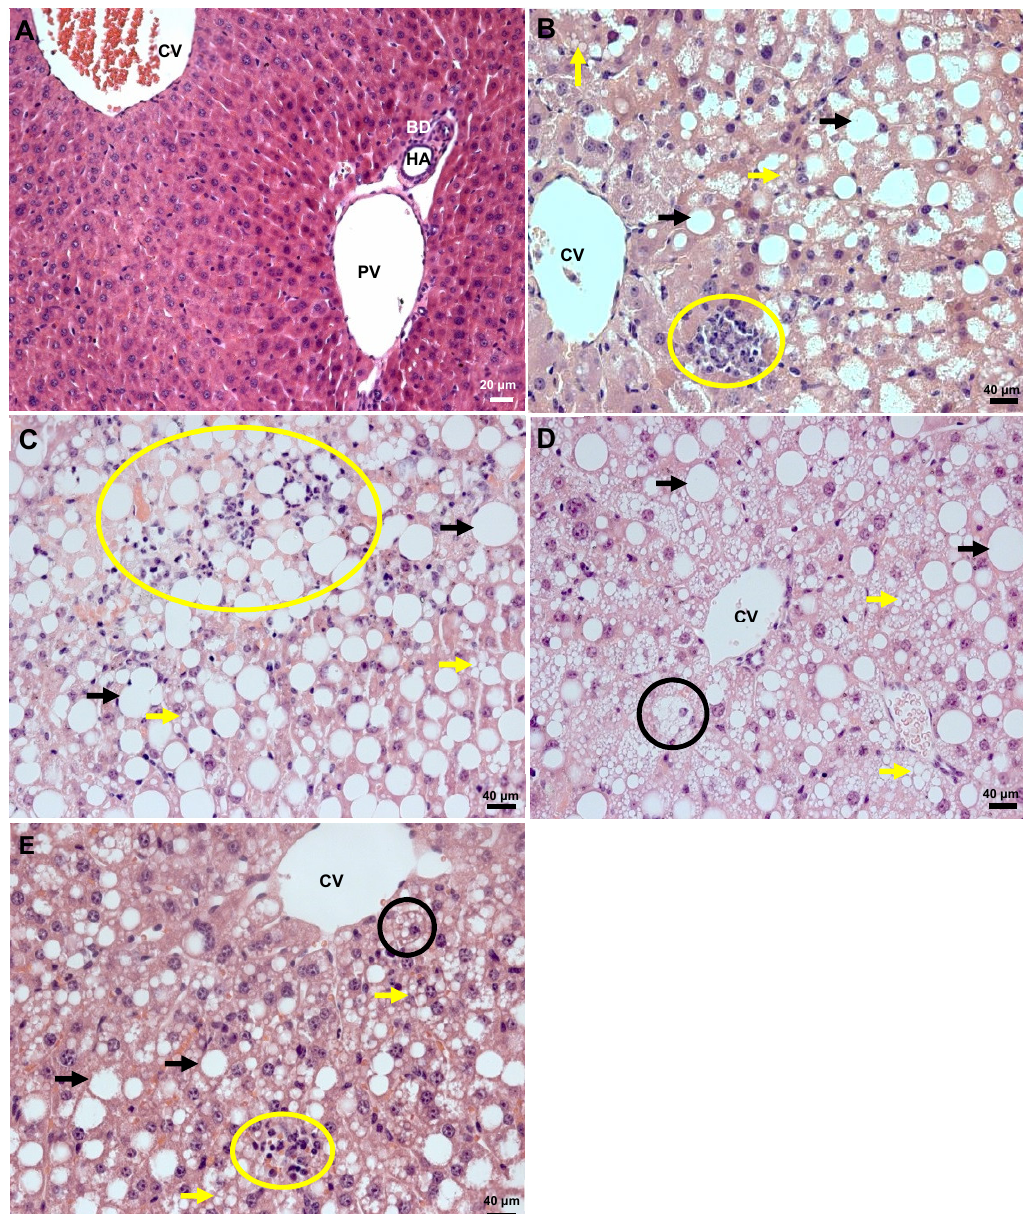
Figure 5. Histological changes in the liver of normal mice and of animals submitted to I / R in the MCD diet treated or not with N -acetylcysteine. This figure shows the ( A ) control group, ( B ) MCD group, ( C , D ) MCD-I / R group, and ( E ) MCD-I / R + NAC group. The black arrows show the presence of macrovesicular steatosis and the yellow arrows indicate microvesicular steatosis. The areas circled in yellow indicate the presence of inflammatory infiltration, and the areas circled in black show hepatocyte ballooning. Hepatic tissue was stained with hematoxylin and eosin (HE). CV = central vein; BD = bile duct; HA = hepatic artery; PV = portal vein. Magnification: 20 × ( A ) and 40 × ( B – E ).